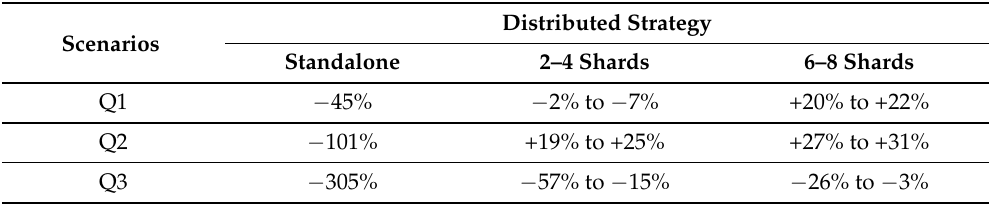
Table 4. Percentages of inferiority (+)/superiority ( − ) in terms of response time between MongoDB, as a baseline, and Relational Postgres.